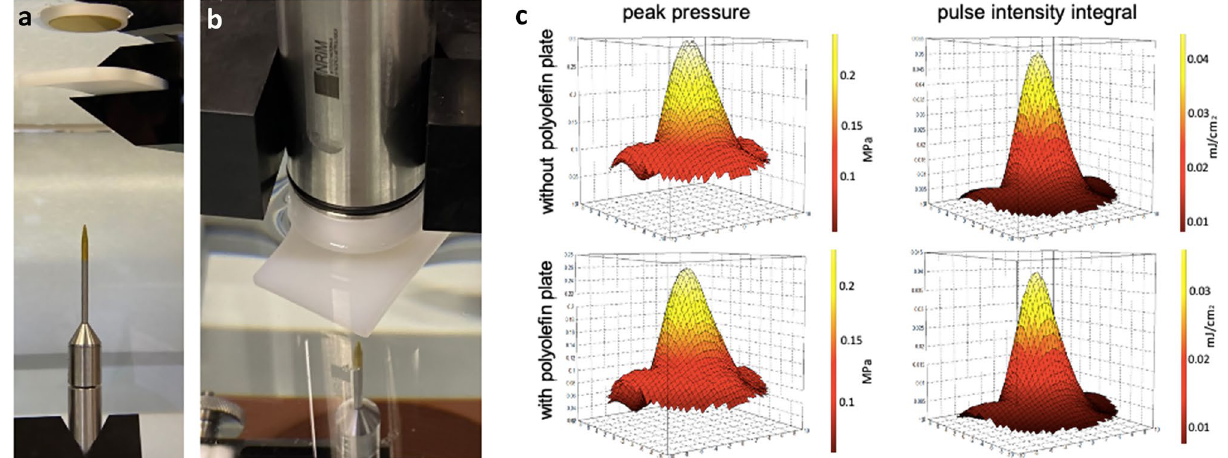
Figure 1. Acoustic characterization of the ultrasound-transparent polyolefin plate. ( a,b ) Measurements setup: ( a ) from top to bottom: surface of TRA08 transducer, polyolefin plate, HNC-0400 hydrophone. ( c ) Comparisons between two-dimensional measured array pressure (left panels) and energy (right panels), with polyolefin plate placed at 15 mm from the transducer surface (lower panels) and without polyolefin plate (upper